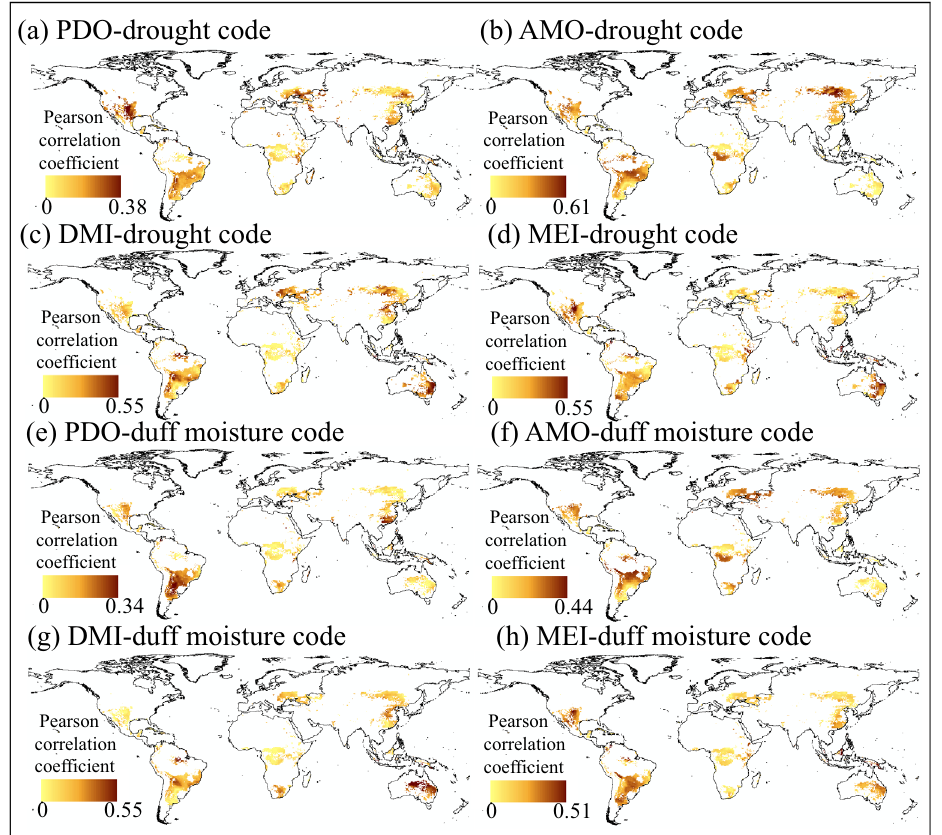
Fig. 9 Distribution map-2 of correlation coefficients of atmospheric–oceanic indices and wildfire-related variables. This dstribution map-2 shows the effects of the four atmospheric-oceanic indices on drought codeand duff moisture code through pearson correlation coefficients. Blank indicates that no wildfiresor change-points have occurred on the grid. PDO: Pacific Decadal Oscillation Index. MEI:Multivariate El Niño-Southern Oscillation Index. AMO: Atlantic Multi-decadal Oscillation Index.DMI: Dipole Mode